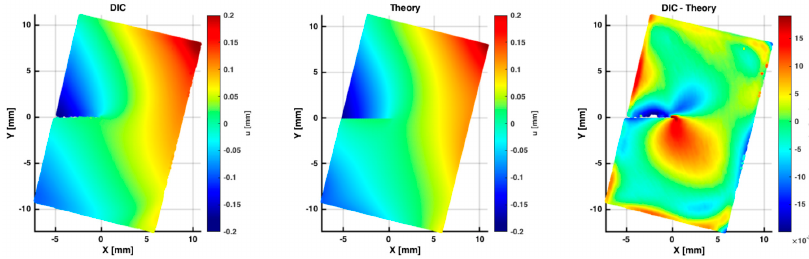
Figure 7. u -displacements field measured by the DIC and the one fitted by the Williams’ model in the case of the specimen AM-10-42-10.2 (Mode II). The SIFs obtained by the full displacement field (DIC) and critical fracture load (PCR) are listed in Table 3. As expected, the K IC measured for the specimens with the sintered crack-like notch (AM), compared to the pre-cracked one (SM), is overestimated of about 40% and 30% for the PCR and the DIC method, respectively. The reason is attributed to the larger radius of the crack-like notch compared to the one, significantly smaller, of the case of the pre-cracked specimens. However, with this specimen geometry, the pre-crack could be induced without having a deviation from its principal axis only for Mode I, and for this reason mixed mode SIFs were investigated only with crack-like notch directly induced by the AM process. For Mode I, an overestimation of about 70% of the DIC results with respect to conventional PCR method can be observed. Going from Mode I to Mode II, this discrepancy becomes negligible. Table 3. Values of the SIFs obtained by critical fracture load and by fitting the displacement field. Specimen Configuration